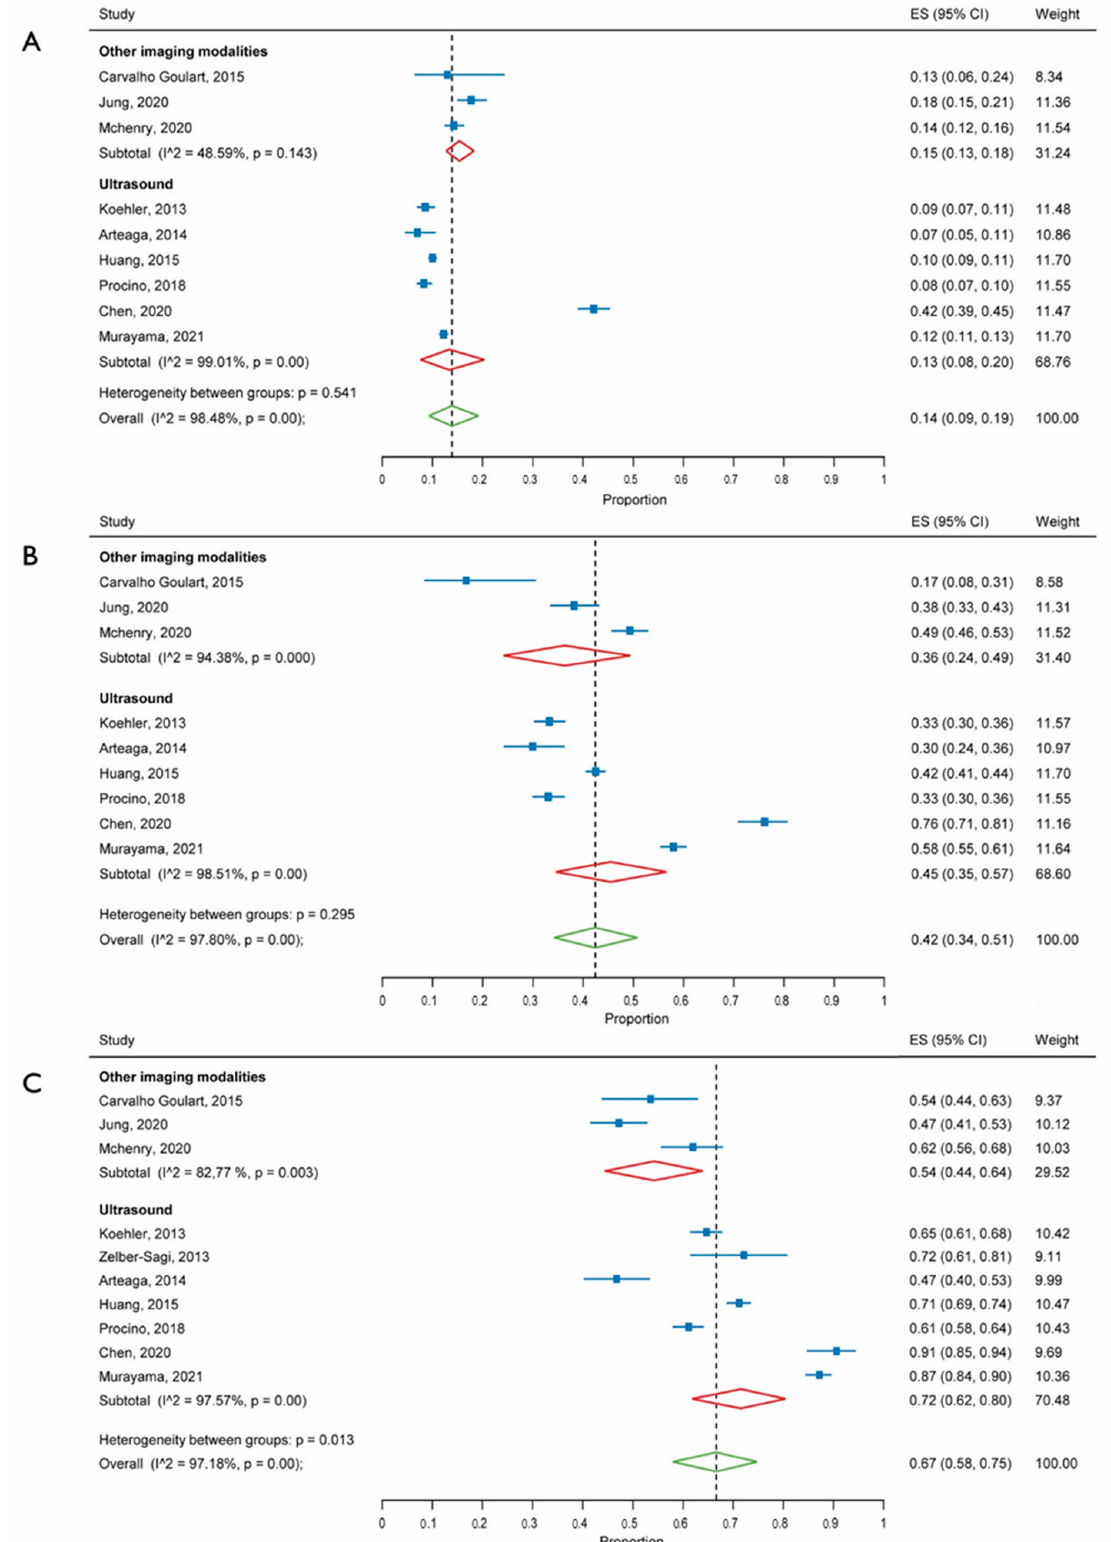
Figure 1. Forest plot of the prevalence of non-alcoholic fatty liver disease in subjects with fatty liver index below 30 ( A ), between 30 and 60 ( B ), or 60 or higher ( C ). 95% CI, 95% confidence interval. References: Koehler, 2013 [12], Zelber-Sagi, 2013 [13], Arteaga, 2014 [14], Carvalho Goulart, 2015 [15], Huang, 2015 [16], Procino, 2018 [17], Chen, 2020 [18], Jung, 2020 [19], McHenry, 2020 [20], Murayama, 2021